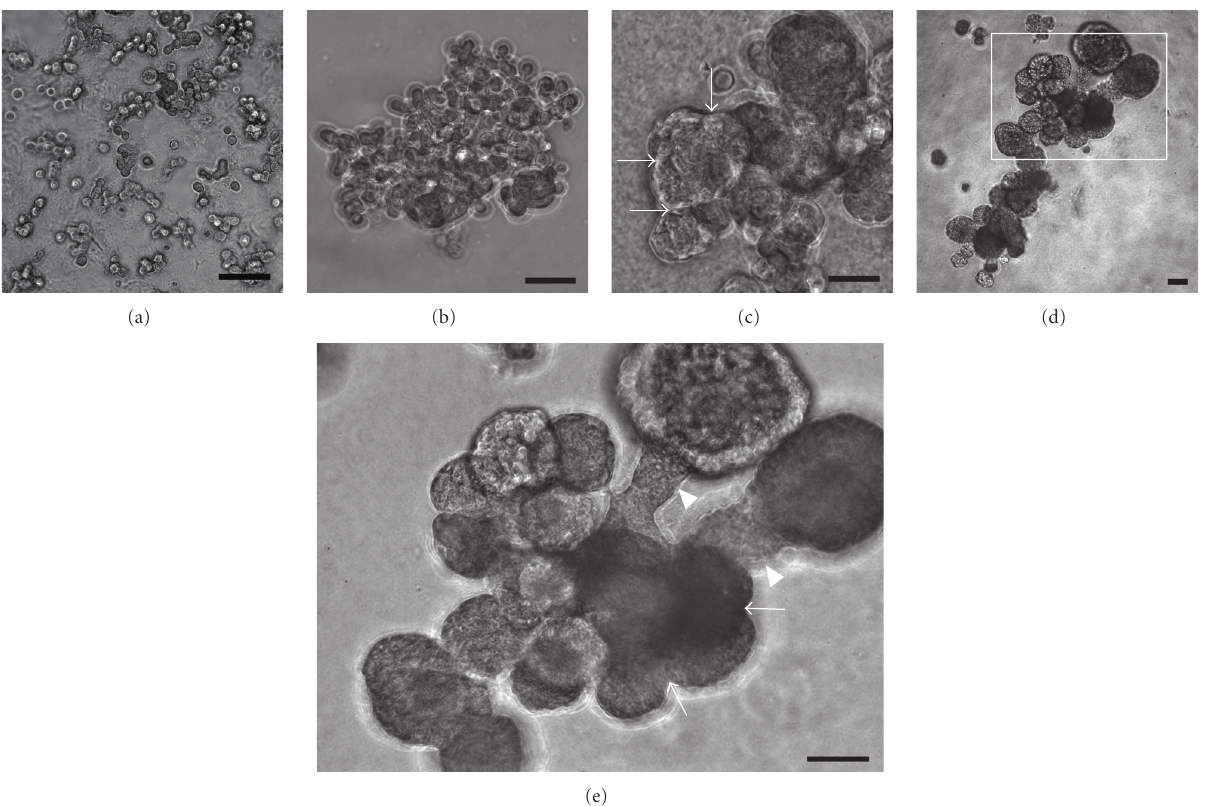
Figure 4: Organization of human SGP cells into a branching organ-like structure. A total of 3,000 cultured human SGP cells were suspended in 100 μ l of di ff erentiation medium and seeded over a thick gel layer in each well of a 96-well plate. The seeded cells were cultured on 2 types of gels: Matrigel and PuraMatrix Peptide Hydrogel (BD Biosciences). Culture media were changed at 3-day intervals in both cell cultures. Matrigel contains both ECM proteins and several growth factors, whereas PuraMatrix peptide hydrogel consists of standard amino acids (1%w/v) and 99% water. The di ff erentiation medium consists of Williams’ E medium supplemented with 1 × ITS-X (GIBCO Invitrogen) and 20 ng/mL of recombinant human EGF (Sigma). (a) shows seeded cells on each gel at day 0. (b) After 7 days, human SGP cells cultured on PuraMatrix failed to form a branching structure and exhibited only loose cell-to-cell aggregation without a round end-bud and stalk. (c), (d), (e) In comparison, human SGP cells cultured on Matrigel organized into a branching structure with stalks and round end buds. (c) shows human SGP cells cultured on Matrigel for 7 days, and (d) shows the culture for 14 days. (e) is a magnified image within the frame of (d). The arrowhead indicates the stalk portion without the lumen in (e). Arrows indicate cleft-like portions in the round end buds in panels (c) and (e). Original magnifications, × 40 (d), × 100 (a, b, c, e). Scale bars = 100 μ